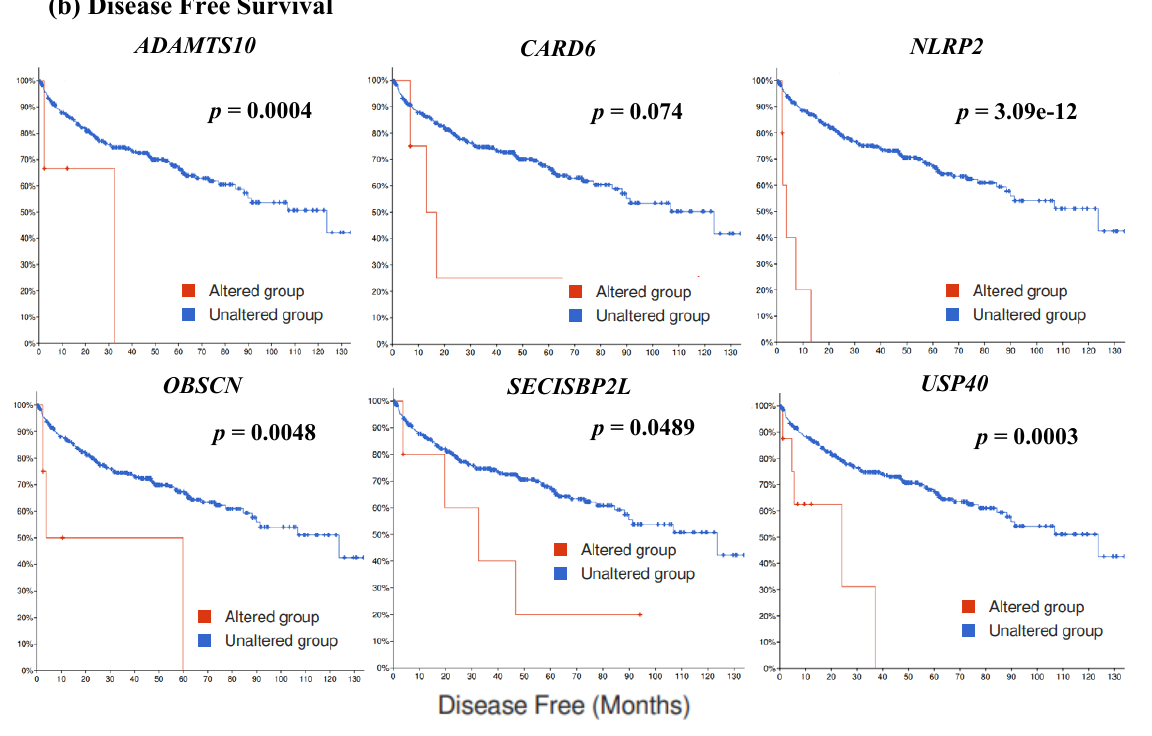
Figure 2. Survival analysis of TCGA_KIRC data for six survival-specific mutated genes. ( a ) Overall survival graphs of ADAMTS10 , CARD6 , and SECISBP2L were obtained from the PanCancer Atlas; overall survival graphs of NLRP2 , OBSCN , and USP40 were obtained from TCGA, Firehose Legacy. ( b ) Disease-free survival graphs of ADAMTS10 , CARD6 , NLRP2 , OBSCN , SECISBP2L , and USP40 were based on data from TCGA, Firehose Legacy.